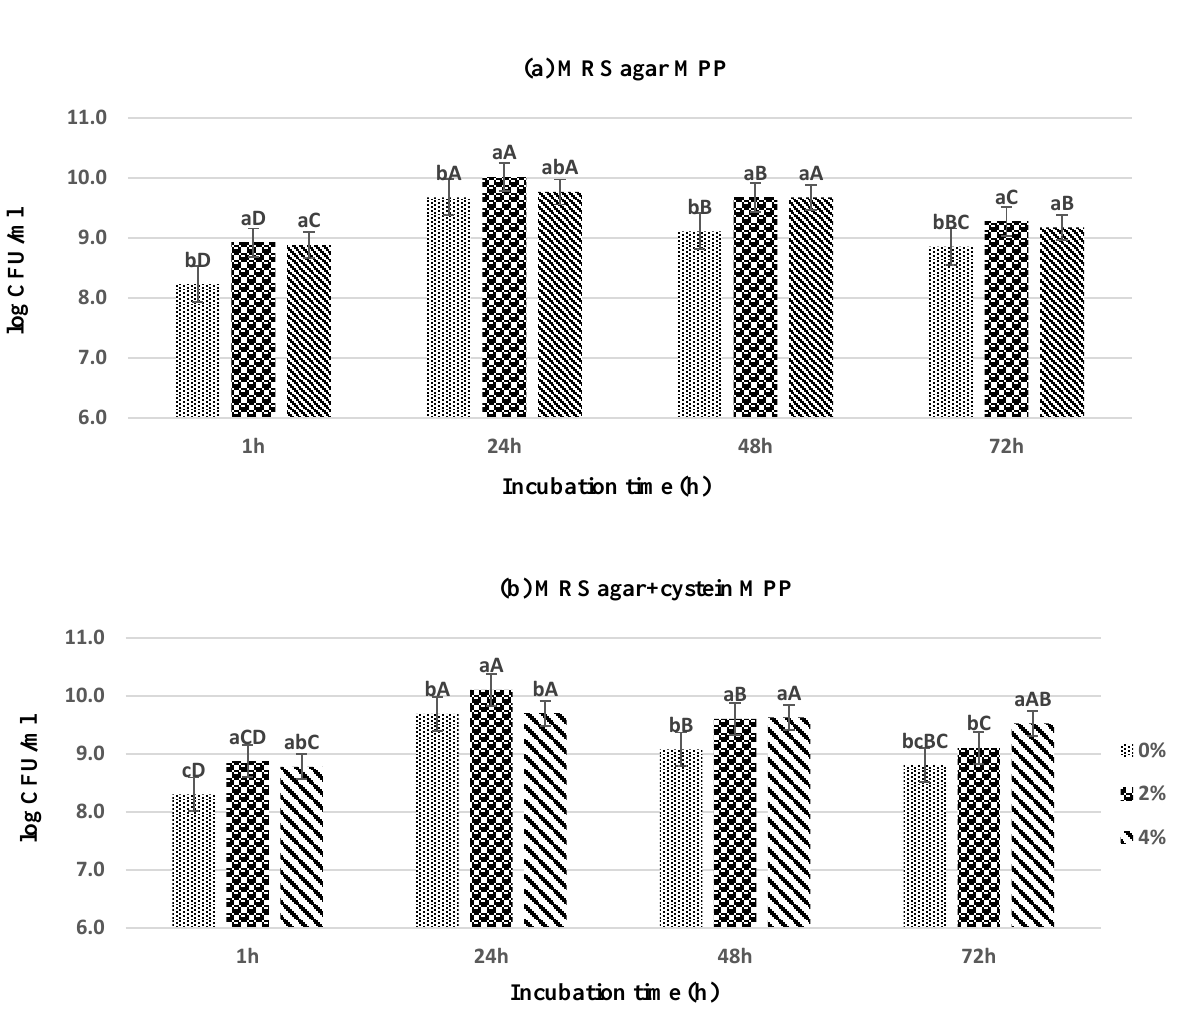
Figure 4. Multi-strain probiotic counts on de Man Rogosa Sharp (MRS) agar ( a ) and MRS agar + cysteine ( b ) during 72 h of anaerobic incubation in MPP supplemented culture media. Different lowercase letters indicate significant difference ( p < 0.05 ) based on the concentration of FPP (0%, 2%, 4%) within same incubation time points and similar probiotic strain. Various uppercase letters indicate significant differences at same concentrations at different incubation time points. Data represent mean values ± standard error ( n = 4).